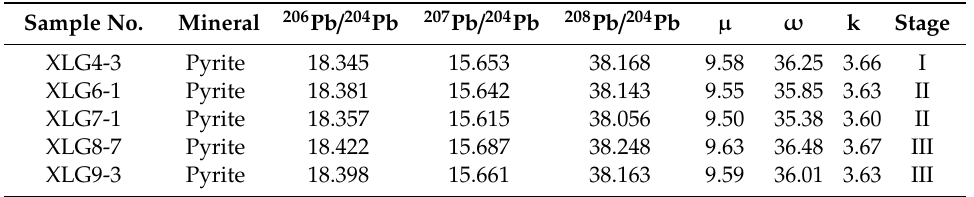
Table 4. The lead isotope values of the Xialiugou